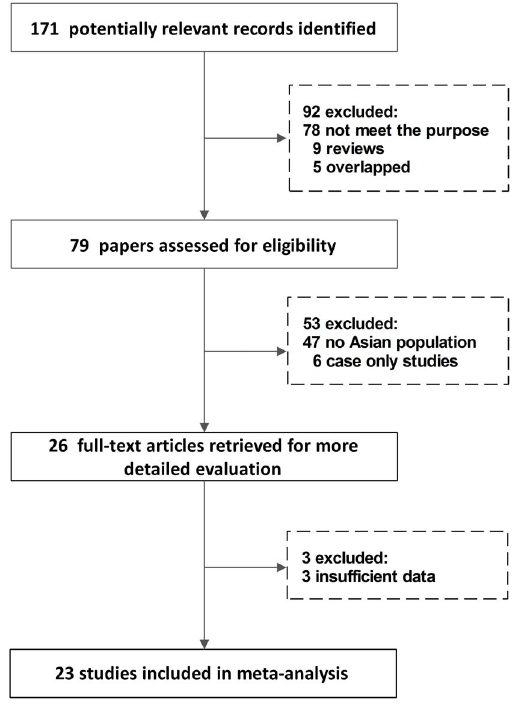
Figure 1. The flow chart of the included studies for a meta- analysis of GSTT1 null genotype and lung cancer risk in Asian population.